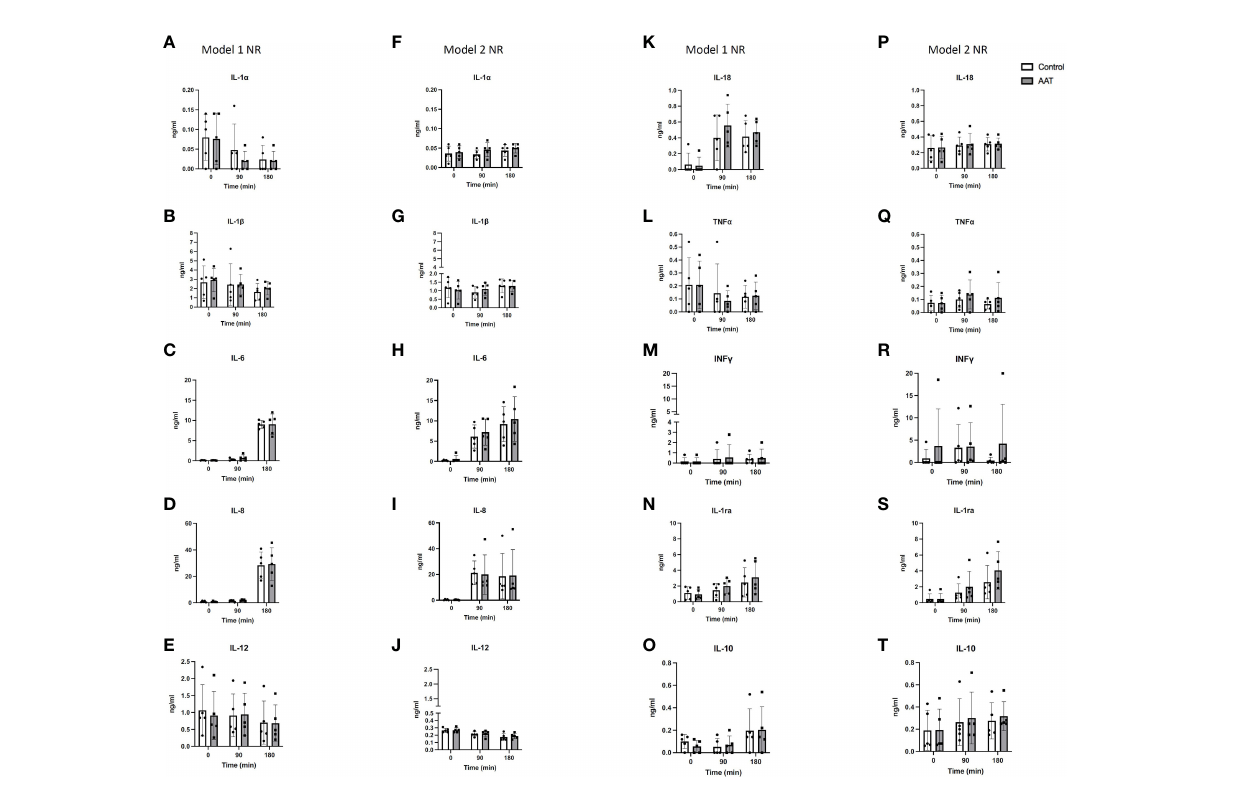
FIGURE 4 | Cytokine concentrations in the perfusate over 3-h normothermic reperfusion (NR) with whole blood following 7-h static cold storage (SCS) in model 1 as well as following 4-h SCS + 3-h normothermic machine perfusion preservation (NMP) in model 2 experiments. Panels (A – E, K – O) represent results for model 1 experiments; and panels (F – J, P – T) represent results for model 2 experiments. Results are shown as mean ±